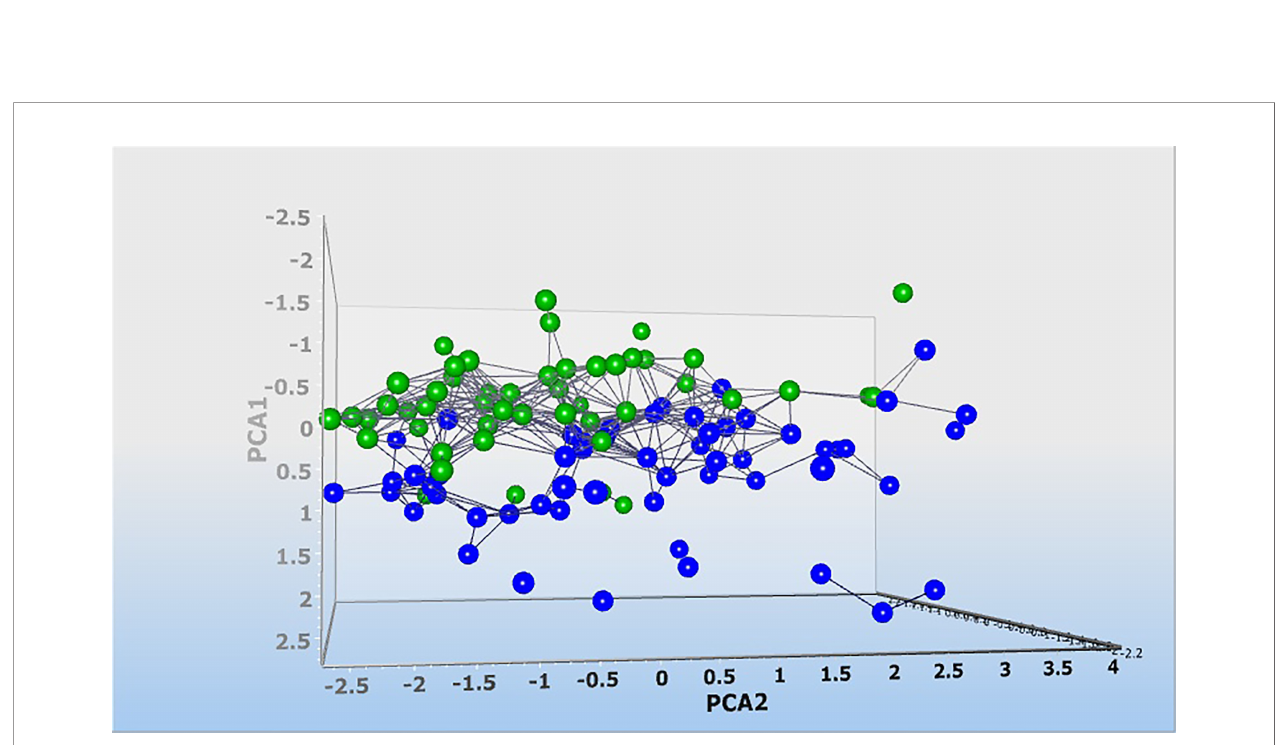
FIGURE 6 | Dynamic principal component analysis (DPCA) of 6 lncRNA expression pro fi les. DPCA was used to fi lter out and exclude lncRNA with low standard deviation. LncRNA PVT1 was excluded and 5 lncRNA expression data were used to clusters samples collected from healthy controls (blue squares) and patients with Parkinson (green squares) into their respective groups. Normalized values were used for principal component